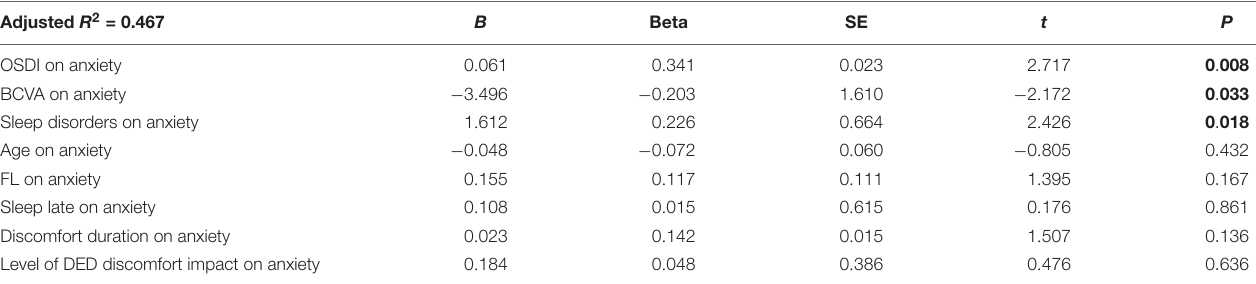
TABLE 8 | Multiple linear regression analysis of association between anxiety scores, demographic and dry eye parameters in patients aged 20–40. Adjusted R 2 = 0.467